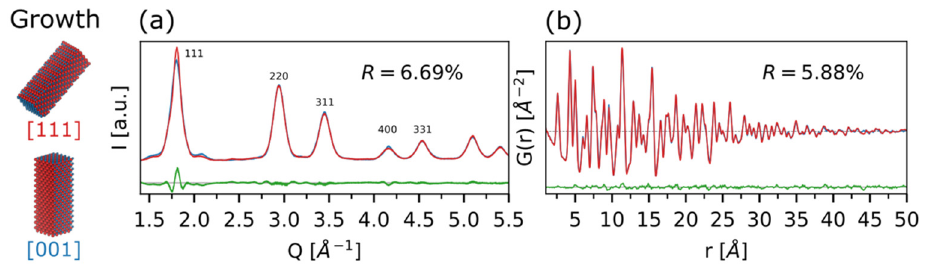
Figure 5. Influence of the growth directions ([100]: red line; [111]: blue trace) on the CdSe simulations in real ( a ) and reciprocal ( b ) spaces. Bragg peaks indices are reported for the DSE simulations in order to highlight the selectivity on their intensities/widths of the two models. Differences between the two growth directions ([111] and [100]) are shown as green traces at the bottom of each plot, together with the corresponding agreement factors, R .